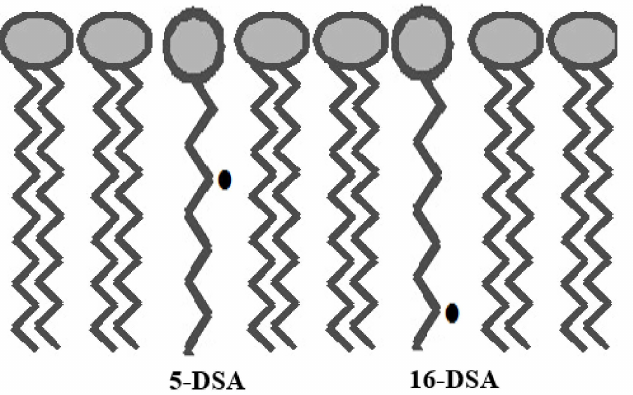
Figure 1. Schematic showing the location of the nitroxide probes, 5-doxyl stearic acid (5-DSA) and 16-doxyl stearic acid (16-DSA), in a phospholipid bilayer. Structures of these two spin probes are presented in Figure 2.